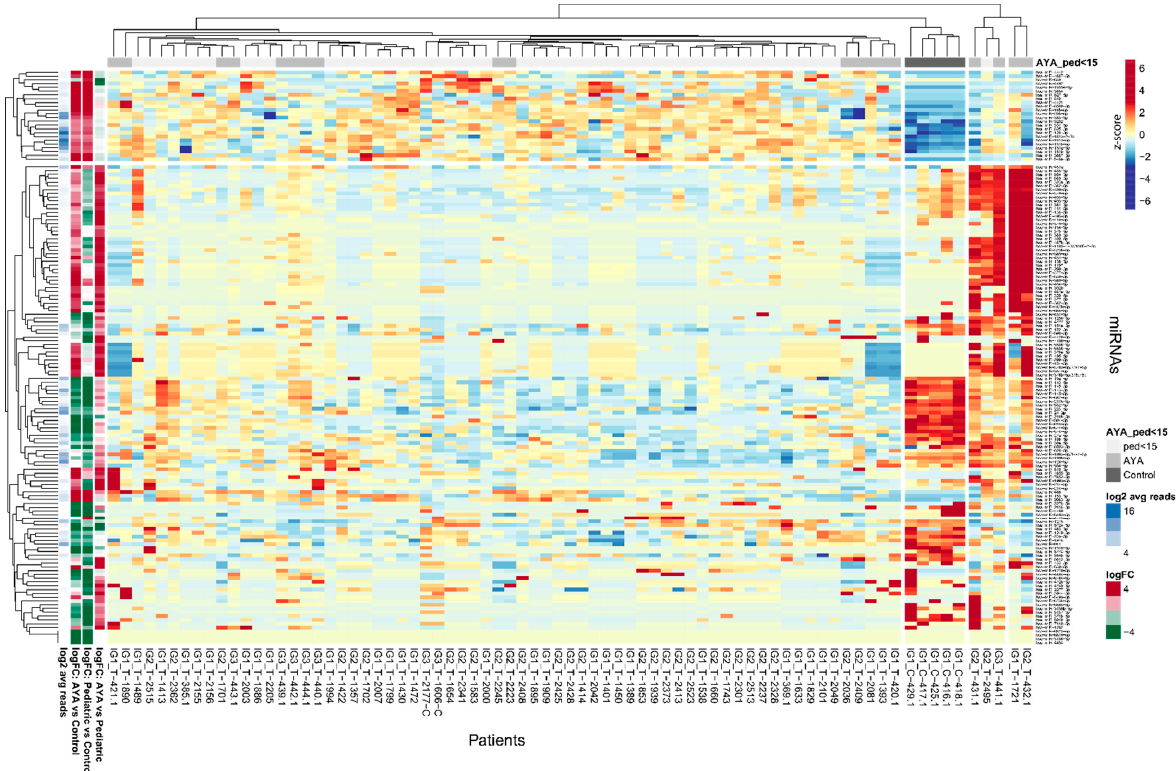
Figure 1. Differentially expressed miRNAs in AYA T-ALL, pediatric T-ALL and control samples. Heatmap and dendrograms of Z-score normalized miRNA expression levels created for miRNAs differentiating T-ALL samples of AYA, pediatric and normal controls (bone marrow T-cells). Rows represent miRNAs; columns represent samples. Dendrograms are based on complete-linkage hierarchical clusterization and Euclidean distances. The fold changes and the abundance of miRNAs (in log scale) are shown on the left side of the plot.